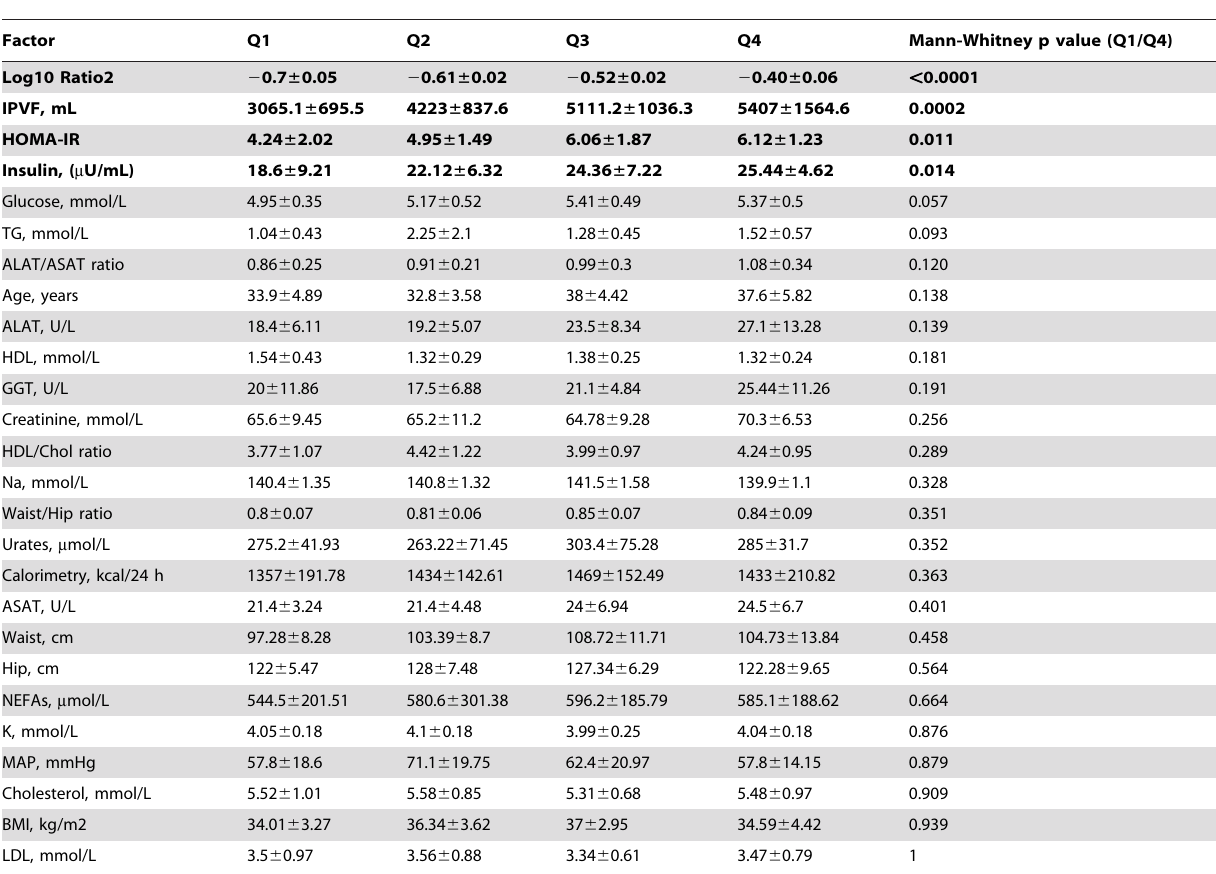
Key: Qi: data for population quartile i according to intraperitoneal/abdominal fat ratio. BMI=body mass index, HDL-C= high density lipoprotein cholesterol, homeostasis model assessment of insulin resistance= HOMA-IR, LDL-C= low density lipoprotein cholesterol, TG= triglycerides, MAP= mean arterial blood pressure, ALAT= alanine aminotransferase, ASAT= aspartate aminotransferase, GGT= gamma-glutamyl transpeptidase, NEFAs=non esterified fatty acids. Data are reported as mean values 6 SD.